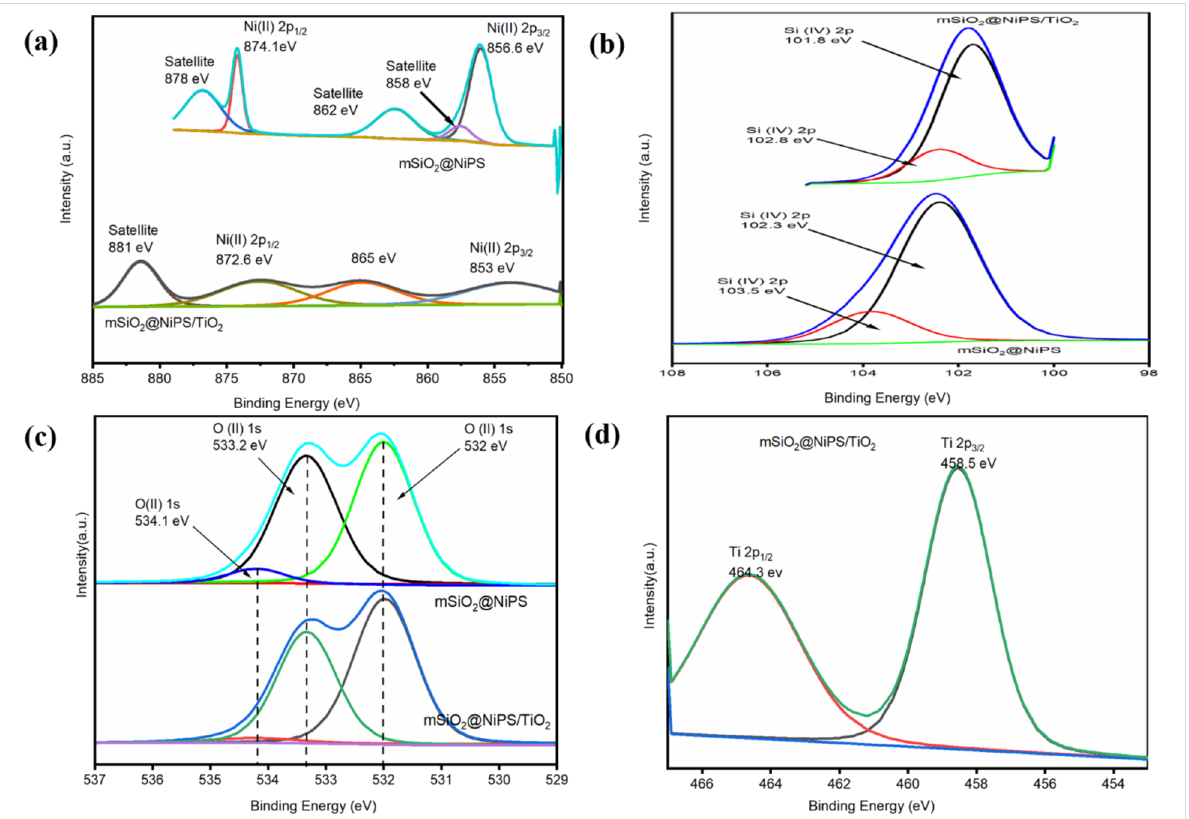
Figure 4: XPS spectrum of mSiO 2 @NiPS and mSiO 2 @NiPS/TiO 2 : (a) Ni 2p, (b) Si 2p, (c) O 1s, and (d) Ti 2p.